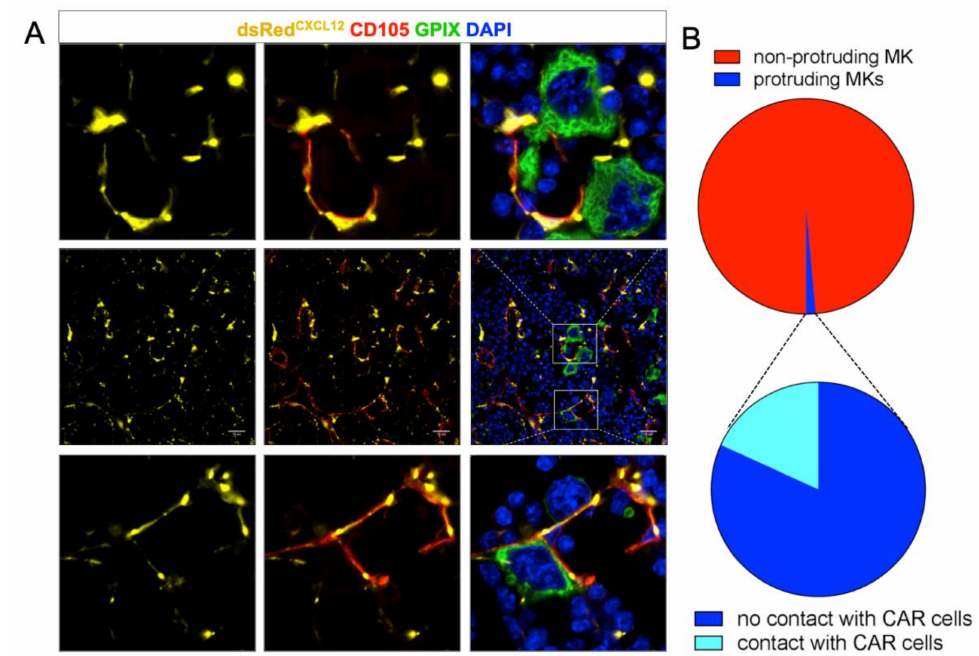
Figure 2. ( A ) dsRed staining of mouse femur sections shows a reticulated pattern (middle row). Resting MKs are in contact with CAR cells (bottom row); the endothelial lining shows pores only when MKs protrude. In these cases, CAR cells were absent or had retracted. ( B ) Quantification of MK-CAR cell contact. About 2% of MKs are protruding the vessel wall; only 25% of them are somewhat in contact with the dsRed expressing CAR cell. Scale bars 20 µ